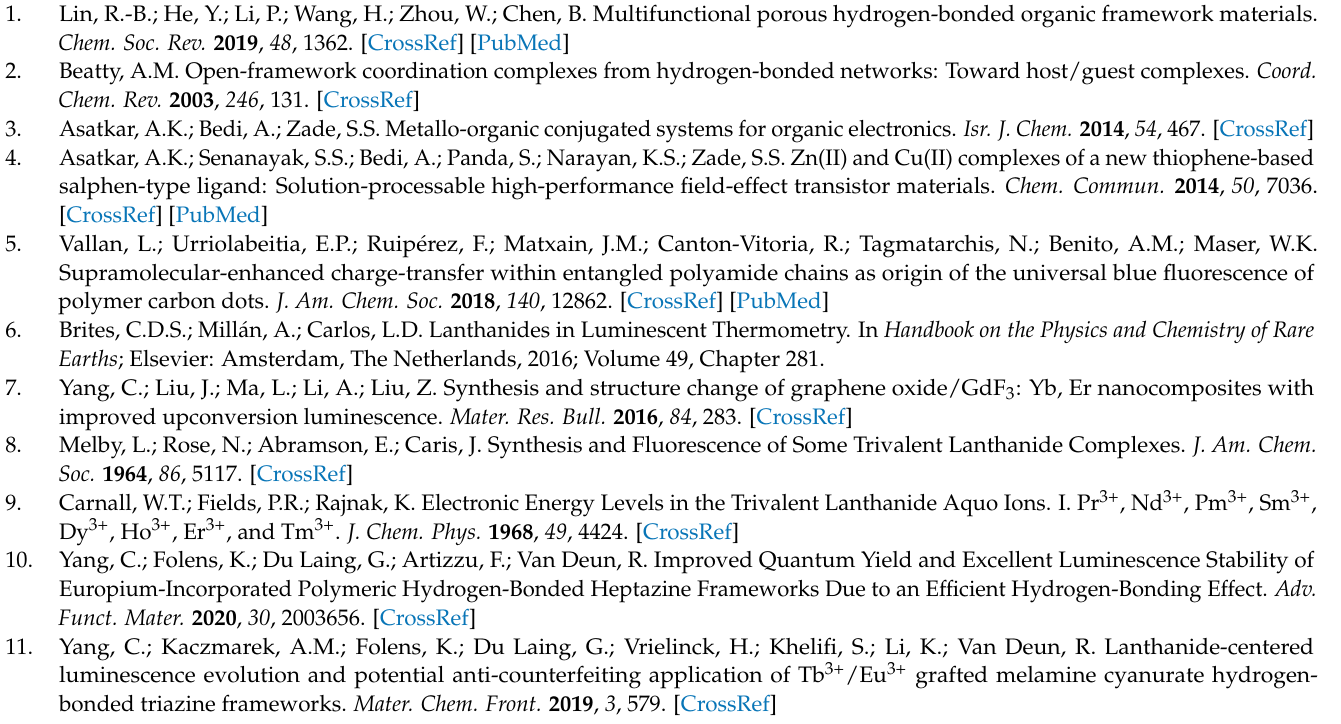
Figure S3: DLS data, Figure S4: FT-Raman spectra, Figure S5: Additional room temperature PL data, Table S3: Assignment of Eu 3+ peaks, Table S4: CIE chromaticity coordinates at room temperature, Table S5: Fitting results of the decay curves, Photophysical Parameters discussion, Figure S6: Quan- tum yield determination spectra, Figure S7: PL decay curves of U-3Eu, Table S6: fitting results of the decay curve of U-3Eu, Figure S8: Energy levels diagrams, Figure S9. Normalized emission spectra at different temperatures, Figure S10. Additional data and fittings for the thermal dependence of the integrated PL intensity, Table S7: Fitting parameters for the thermometric equation, Table S8: CIE coordinates at different temperatures, Figure S11: Dependence of ∆ 02/01 from the temperature, Figure S12: S r % for ∆ 01 = I 11 /I 02 , Figure S13: Linear trend of experimental Sr% values with 1/T 2